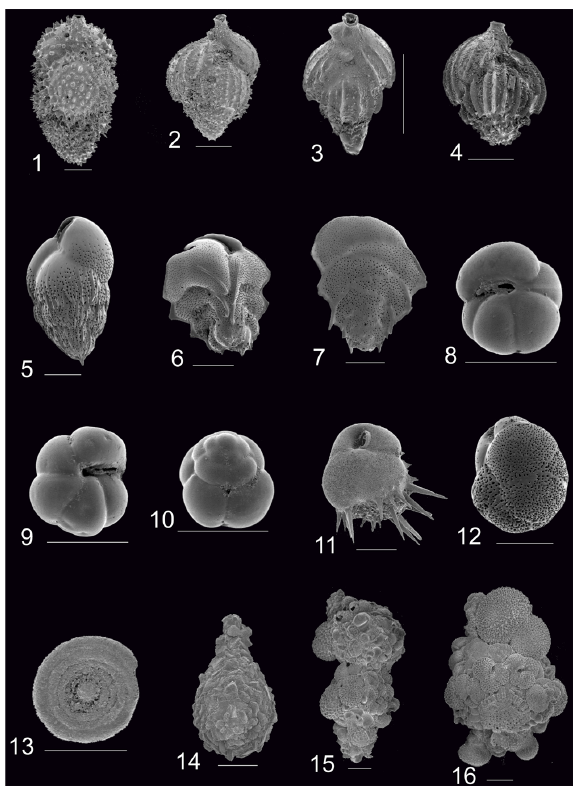
Fig. 9. SEM pictures of the main foraminiferal taxa. Scale bar = 100µm. 1: Uvigerina auberiana d’Orbigny, 1839, PA8 (1–1.5cm), > 150µm. Regrouped with Uvigerina peregrina s.s. under U. pere- grina